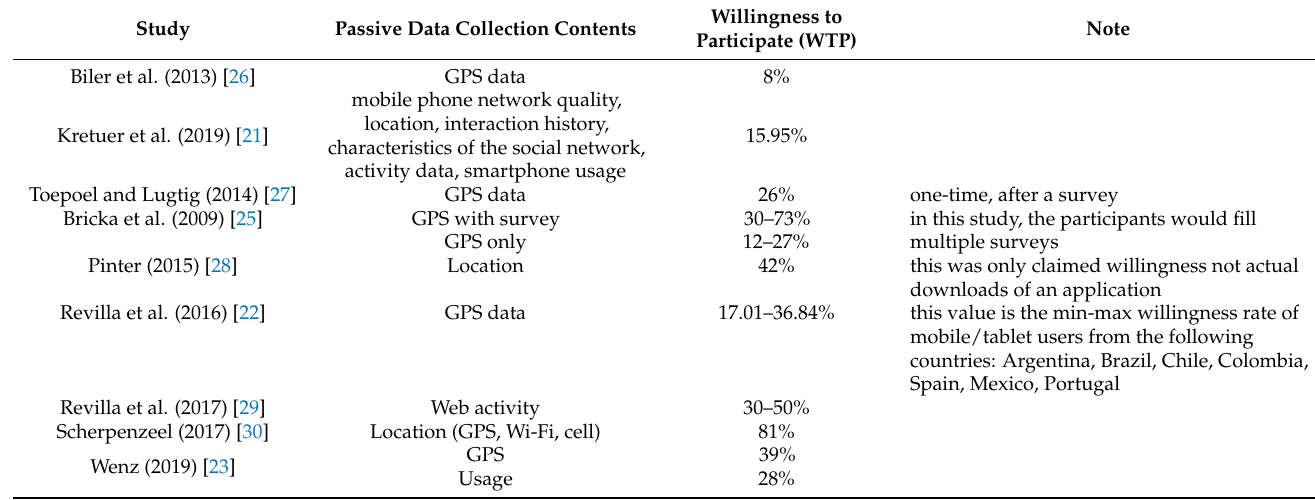
Table 1. The ratio of willingness to share data in selected